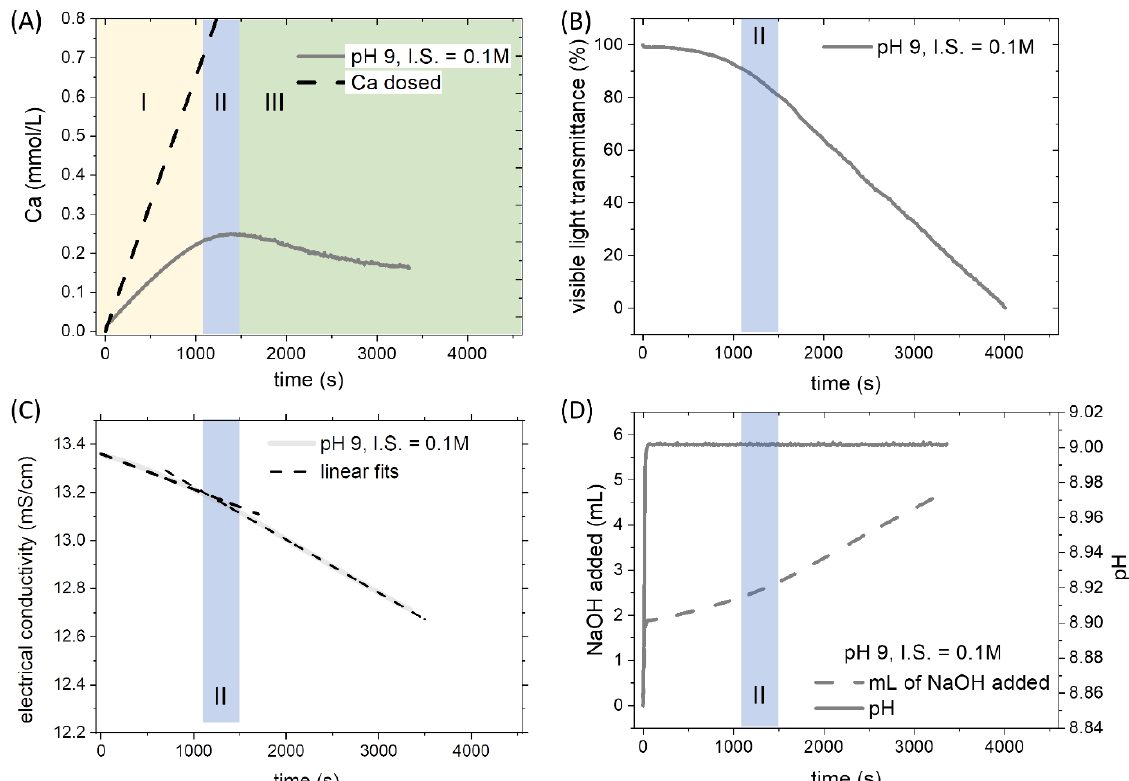
Figure 1. General overview of a titration experiment (pH 9, ionic strength 0.15 M) without Pb 2+ . ( A ) The signal recorded by the CaISE is converted into the concentration of free calcium after specific calibrations of the electrode in carbonate-free solutions. Latin numbers indicate three stages of the experiment: prenucleation (I), nucleation (II), and growth (III). ( B ) The potential recorded by the Optrode is converted in a percent scale to normalize the value along with the different experimental runs. The drop of visible light transmittance corresponds to the development of turbidity. This phenomenon is related to the formation of solid particles in the initially homogenous solution. ( C ) The electrical conductivity of the solution shows a slope change in correspondence of the nucleation stage. ( D ) The pH of the solution was maintained constant during the experiments thanks to the automatic addition of NaOH. The consumption of NaOH shows an acceleration after the nucleation of the solid phase.